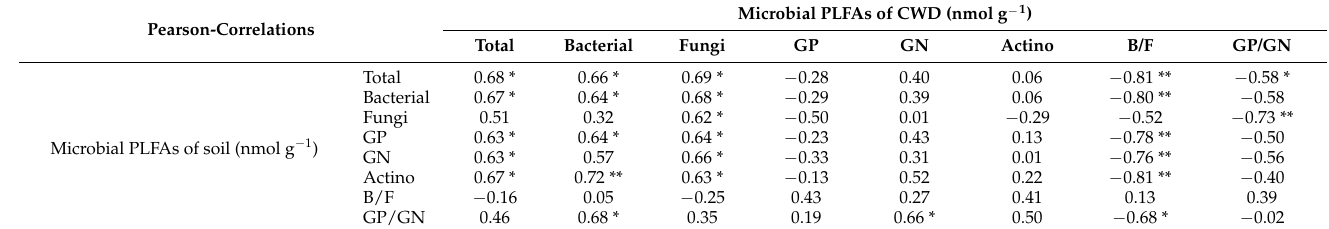
Table 7. The Pearson correlations between the microbial PLFAs (nmol g − 1 ) of CWD and soil. CWD: coarse woody debris; Total: total PLFA; Actino: actinomycete; B/F: the ratio of bacteria to fungi; GP/GN: the ratio of GP to GN. * p < 0.05, ** p < 0.01.